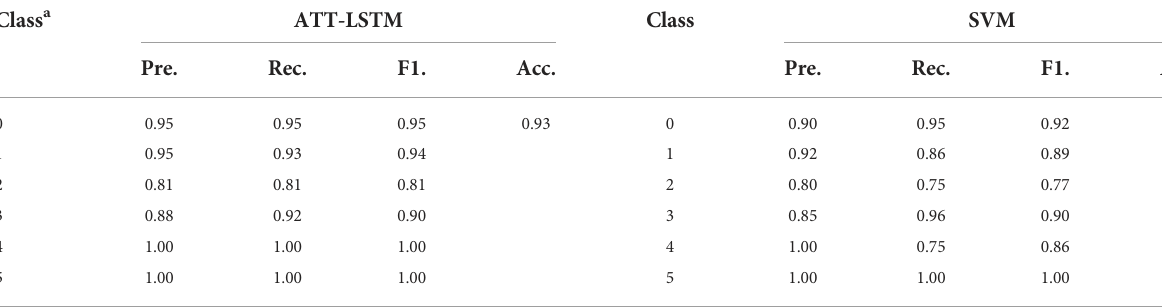
TABLE 3 The prediction results of ATT-LSTM and SVM models by fusing spectral data and color features. Class a ATT-LSTM Class SVM Pre. Rec.